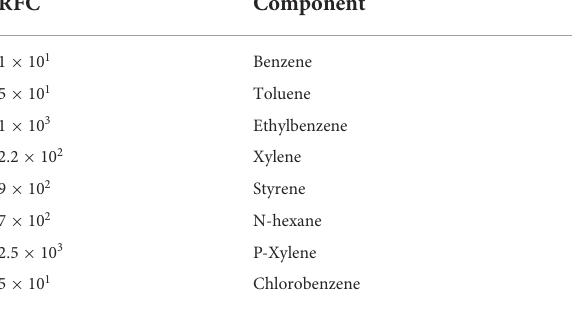
TABLE 5 The values of RFC for VOCs (35).